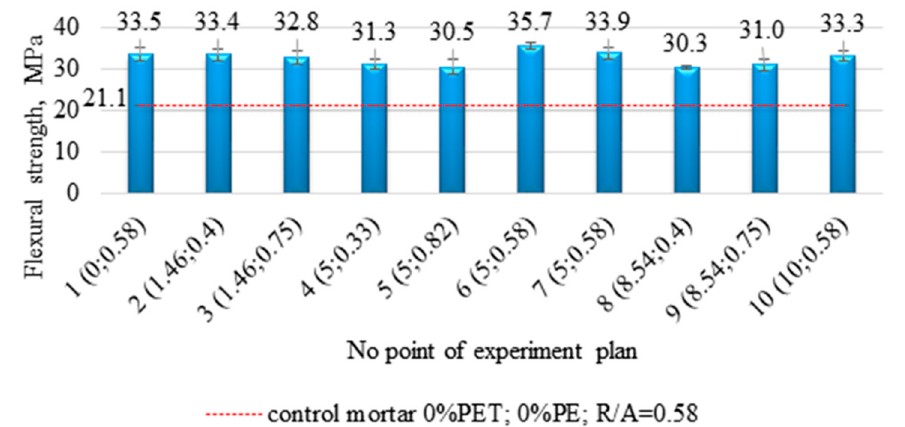
Figure 7. The compilation of the mean values of the flexural strength at different points of the experimental plan.